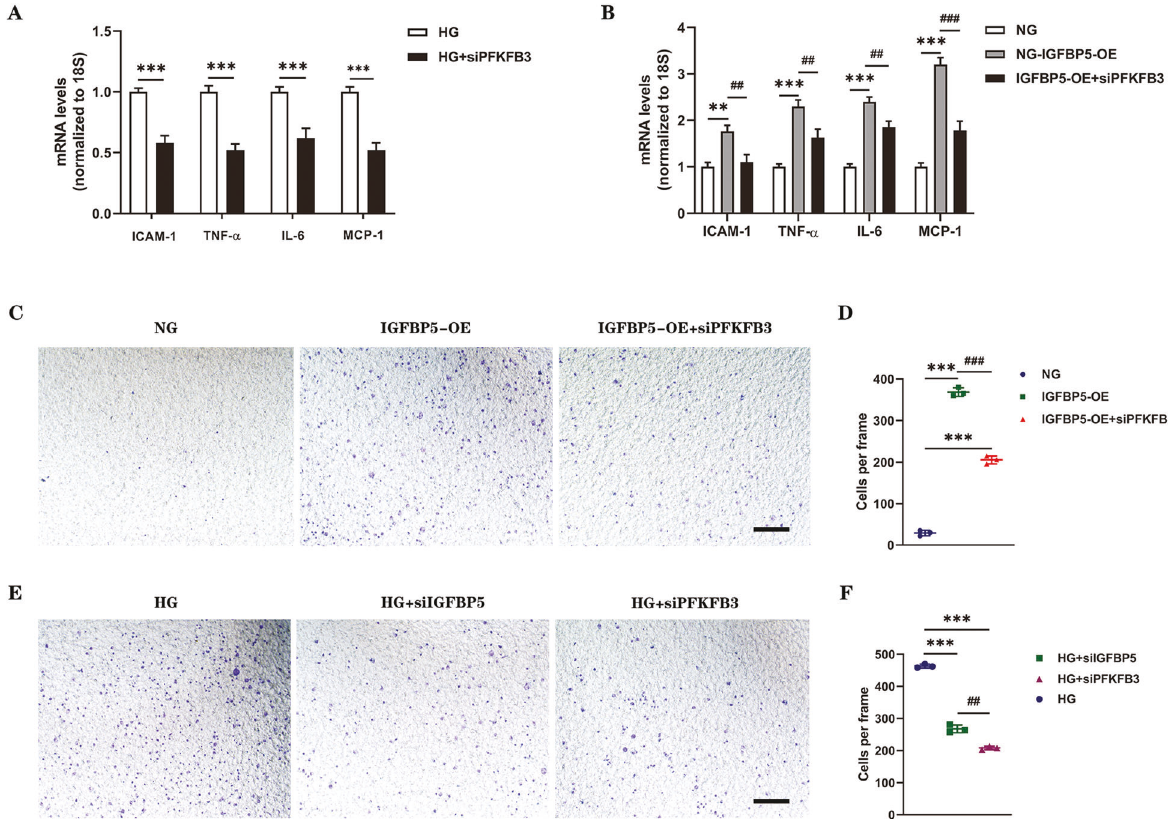
Fig. 5 PFKFB3 de fi ciency inhibits endothelial in fl ammation and macrophage migration. A RT – PCR analysis of the mRNA levels of ICAM-1, TNF- α , IL-6, and MCP-1 in HUVECs transfected with or without siPFKFB3 under HG conditions. n = 3. B RT – PCR analysis of the mRNA levels of ICAM- 1, TNF- α , IL-6, and MCP-1 in control HUVECs and IGFBP5-OE cells with or without siPFKFB3 treatment under NG conditions. n = 3. C Migration of THP-1 cells that were cocultured in Transwell systems with control or IGFBP5-OE cells (with or without siPFKFB3 involved) in NG conditions for 36 h. Scale bar, 100 μ m. D Statistical analysis was performed by counting the number of migrated cells in the different groups. n = 3. E Migration of THP-1 cells that were cocultured in Transwell systems with HUVECs (transfected with siCTRL, siIGFBP5, or siPFKFB3) under HG conditions for 36 h. Scale bar, 100 μ m. F Statistical analysis was performed by counting the number of migrated cells in the different groups. n = 3. The data are shown as the mean ±SD in all statistical graphs. ** P <0.01, *** P <0.001; ## P < 0.01, ### P